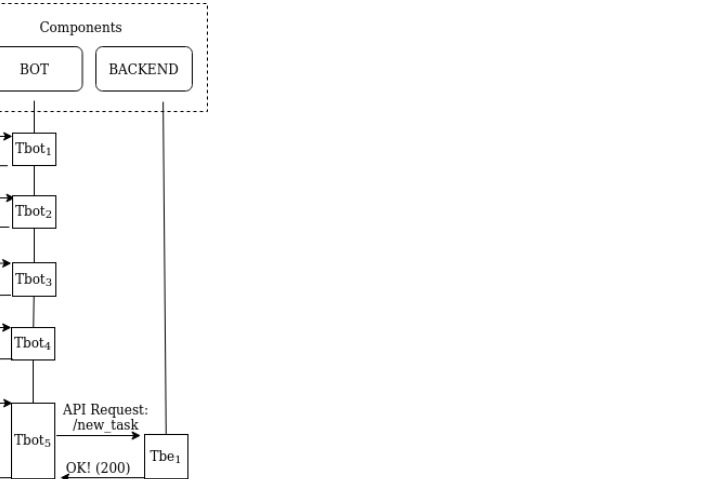
Figure 7. Steps executed by different tasks on the Rimay app. The coordinator and the volunteers talk through the Telegram